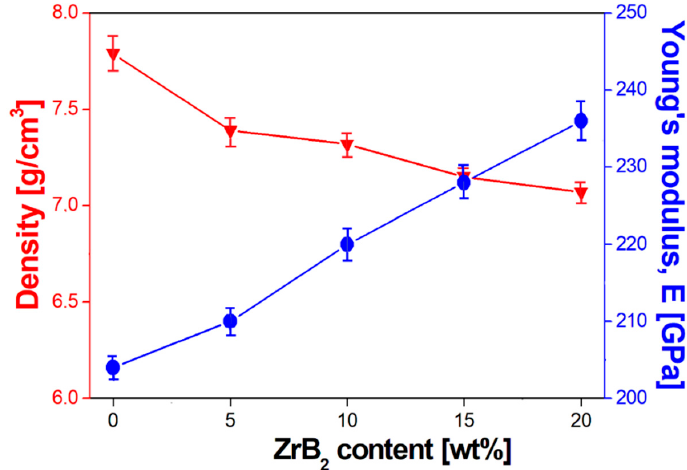
Figure 9. Effect of ZrB 2 content on density and Young’s modulus.